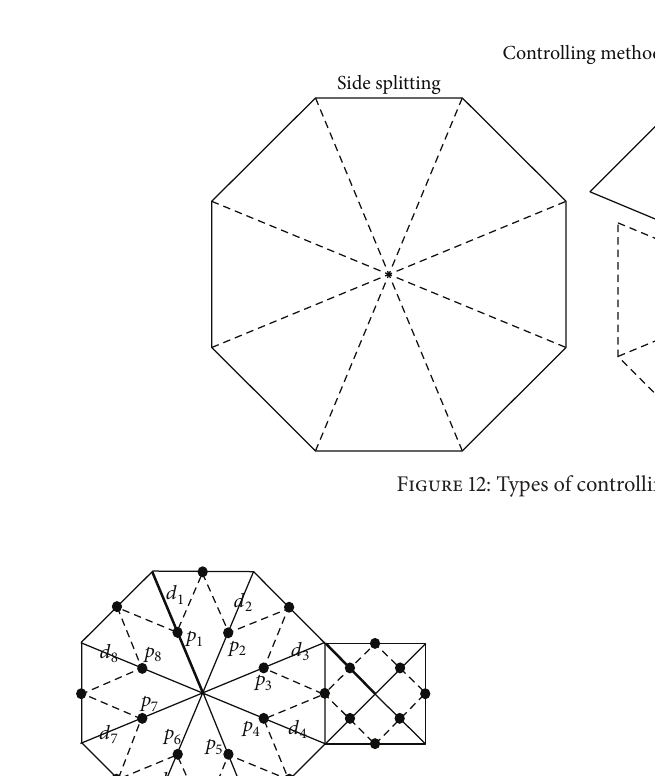
Figure 11: Transformation of 4.8.8 combination.